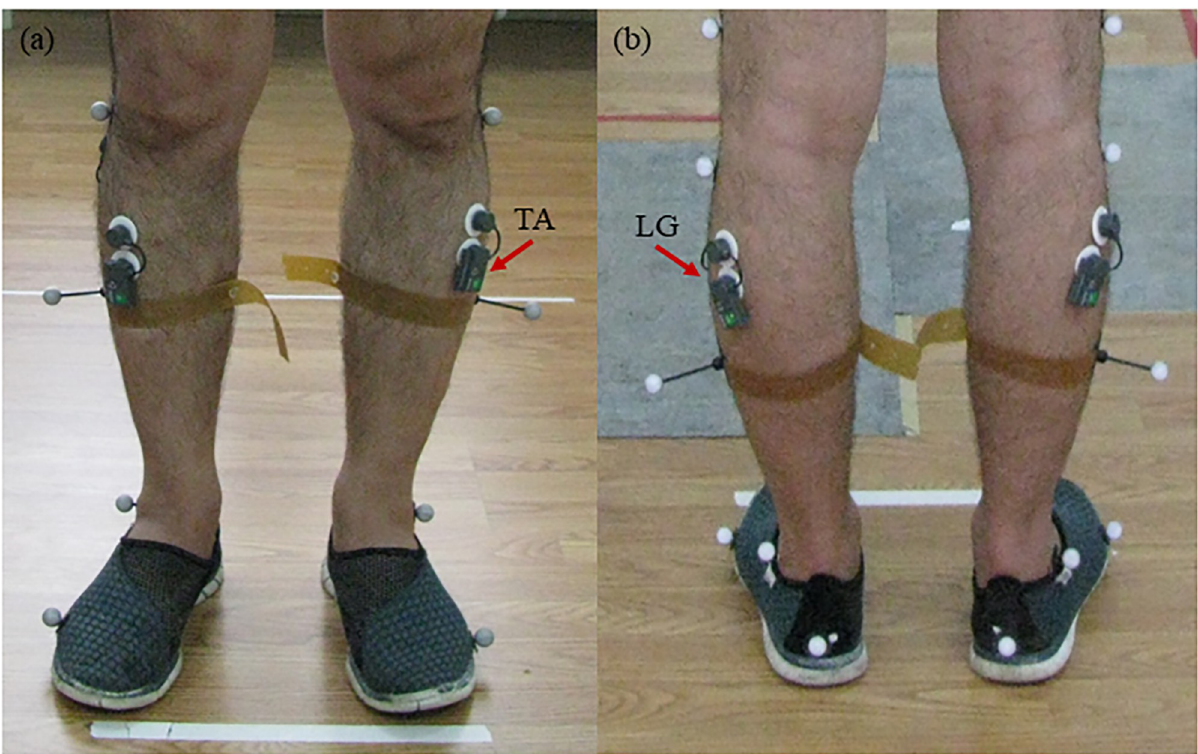
Fig 1. The positions of surface electromyography (sEMG) electrodes. (a) In the front view, (b) in the back view.